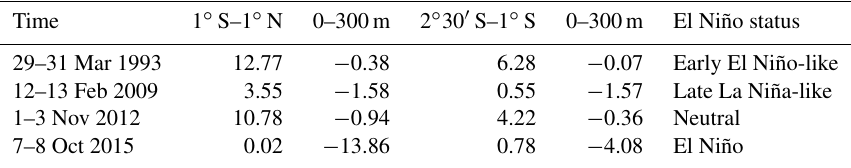
Table 2. Summed zonal positive (eastward) and negative (westward) ADCP transports inSv (10 6 m 3 s − 1 ) in the equatorial channel at 85 ◦ 50 (cid:48) W in March 1993, February 2009, and November 2012 and at 85 ◦ 30 (cid:48) W in October 2015 as well as the related El Niño status. The velocity data were slightly smoothed and extrapolated to the